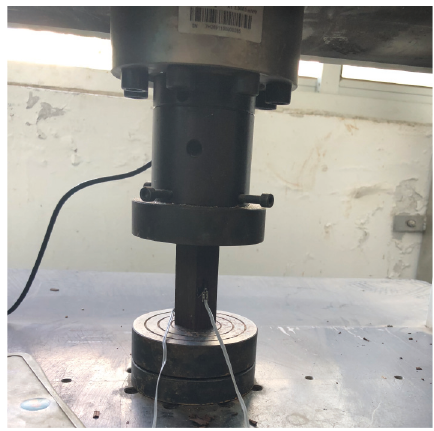
Figure 4: Compression test of the bamboo scrimber.